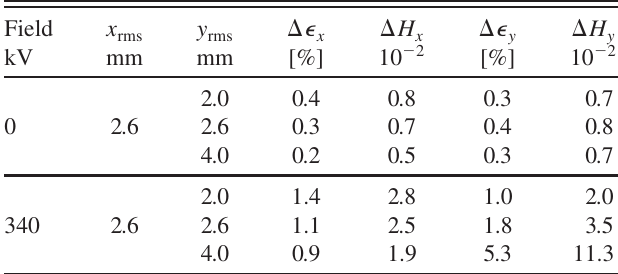
TABLE VII. Aspect ratio dependence—uniform beam ( (cid:11) 1 : 5 ; (cid:11)